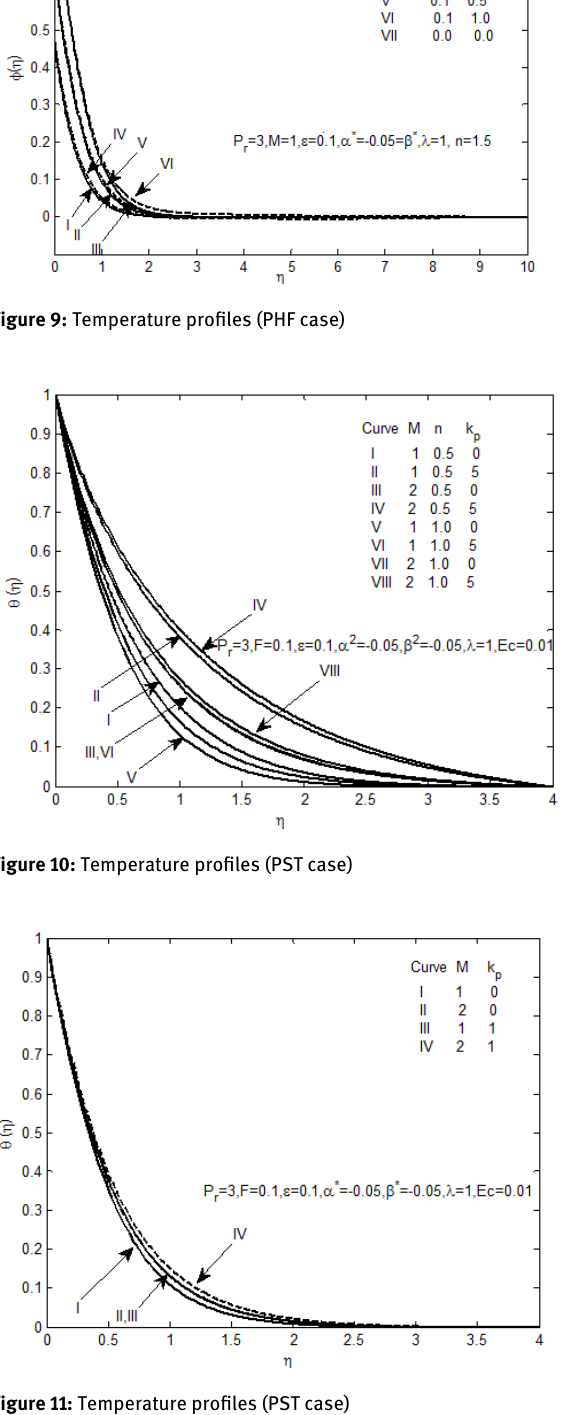
Figure 11: Temperature profiles (PST case)